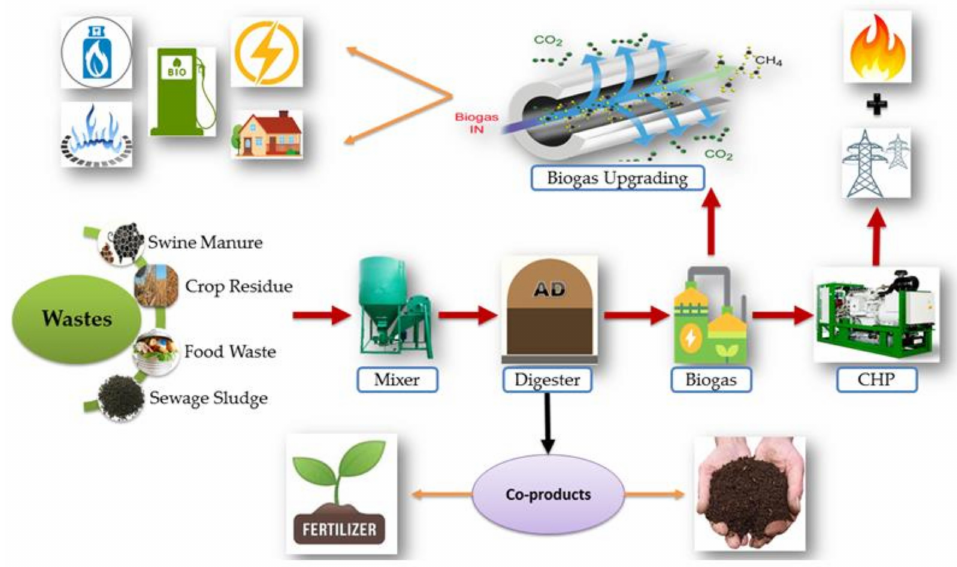
Figure 2. Schematic diagram of biogas production processes. CHP: Combined heat and